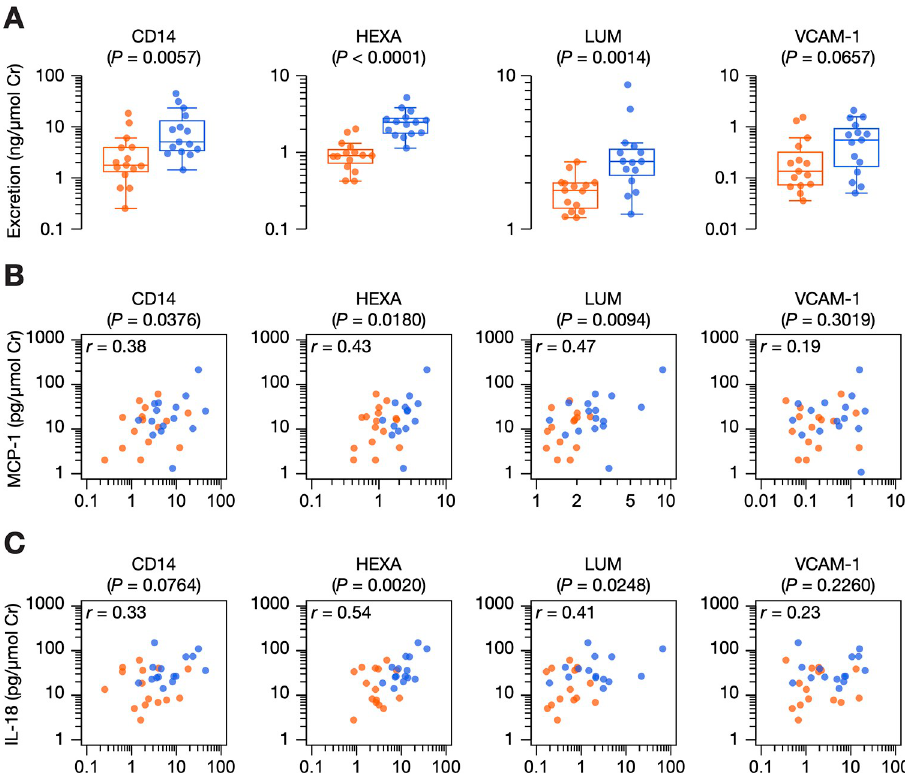
Fig 4. Internal validation of four proteins in a second, independent cohort. Individual data points are shown for the 15 youths with diabetes (blue) and 15 youths without diabetes (orange). (A) Urinary excretion of four proteins selected for validation by enzyme-linked immunosorbent assay. P values, determined by the Mann-Whitney test, are shown for each protein. (B) Pearson correlations between log-transformed urinary excretion of four proteins and that of monocyte chemoattractant protein-1 (MCP-1). (C) Pearson correlations between log-transformed urinary excretion of four proteins and that of interleukin-18 (IL-18). CD14, monocyte differentiation antigen CD14; HEXA, beta- hexosaminidase subunit alpha; HC, non-diabetic youths; LUM, lumican; T1D, youths with type 1 diabetes; VCAM-1, vascular adhesion